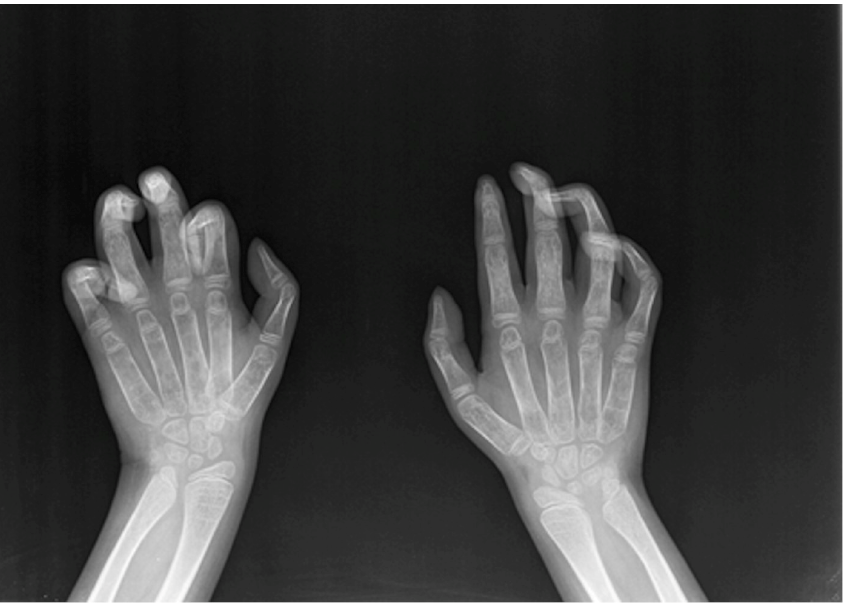
Figure 1. Claw hand and clinodactyly of the left II, III, IV, V finger and clinodactyly of the right III, IV, V finger.